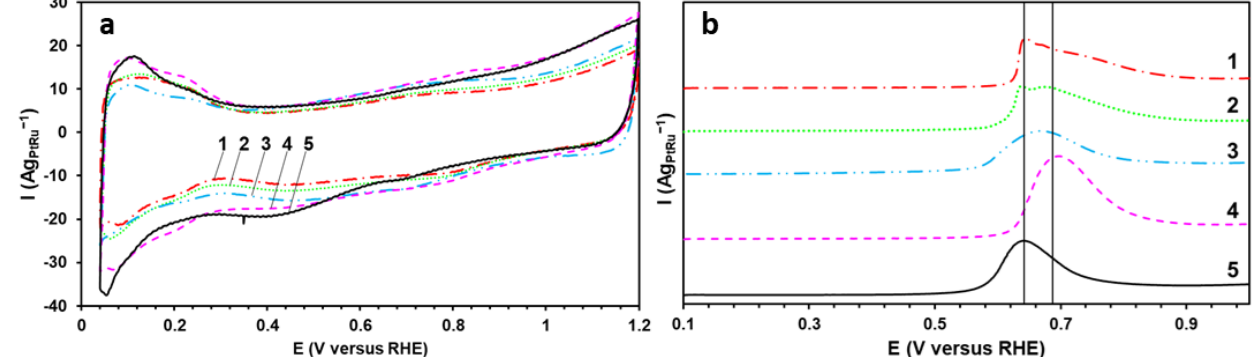
Figure 4. ( a ) The cyclic voltammograms of the catalysts. The potential sweep rate is 20 mVs −1 . ( b ) The cyclic voltammograms of the CO oxidation. The electrolyte is 0.1 М HClO 4 saturated with argon at the atmospheric pressure. 1 — BH; 2 — BHC; 3 — BHA; 4 — P; 5 — PtRu-AA.